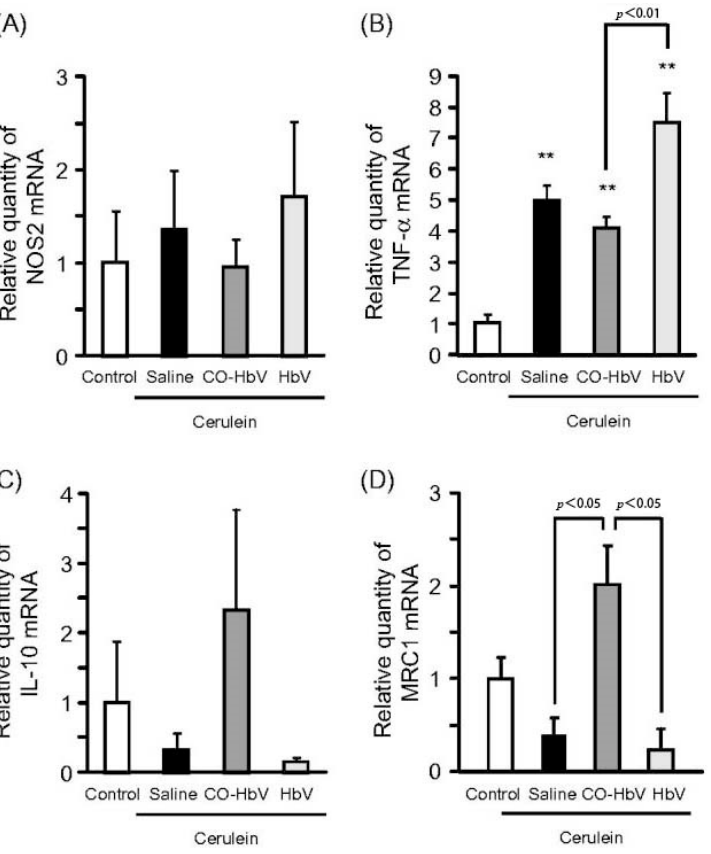
Figure 1. Effect of CO-HbV on M1 and M2 type macrophage polarization in the pancreas in a model of acute pancreatitis. ( A ) mRNA expression levels of NOS2 (M1 macrophage marker) in the physiological saline group, HbV group and CO-HbV treatment group. ( B ) mRNA expression levels of TNF- α (M1 macrophage marker) in the physiological saline group, HbV group, and CO-HbV treatment group. ( C ) mRNA expression levels of IL-10 (M2 macrophage marker) in the physiological saline group, HbV group, and CO-HbV treatment group. ( D ) mRNA expression levels of MRC1 (M2 macrophage marker) in the physiological saline group, HbV group, and CO-HbV treatment group. (The expression levels of the above mRNAs were measured in pancreatic tissues collected at the 12th hour after the start of mouse modeling with cerulein). ** p < 0.01 versus control. Reprinted from [70]. Copyright